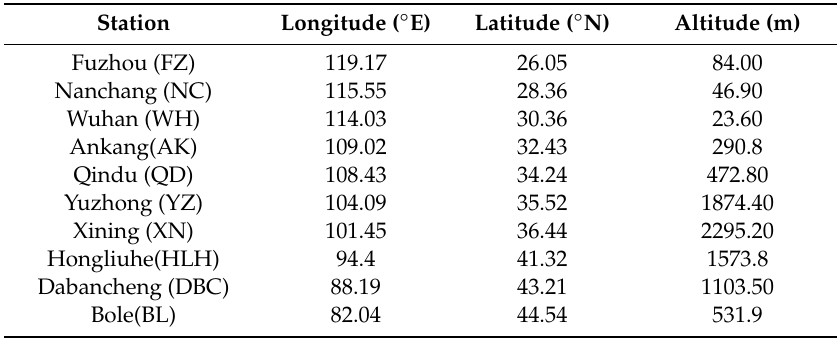
Figure 1. Digital elevation model (DEM) and distribution of the ten meteorological stations and precipitation contours. Table 1. Basic information concerning the ten meteorological stations.